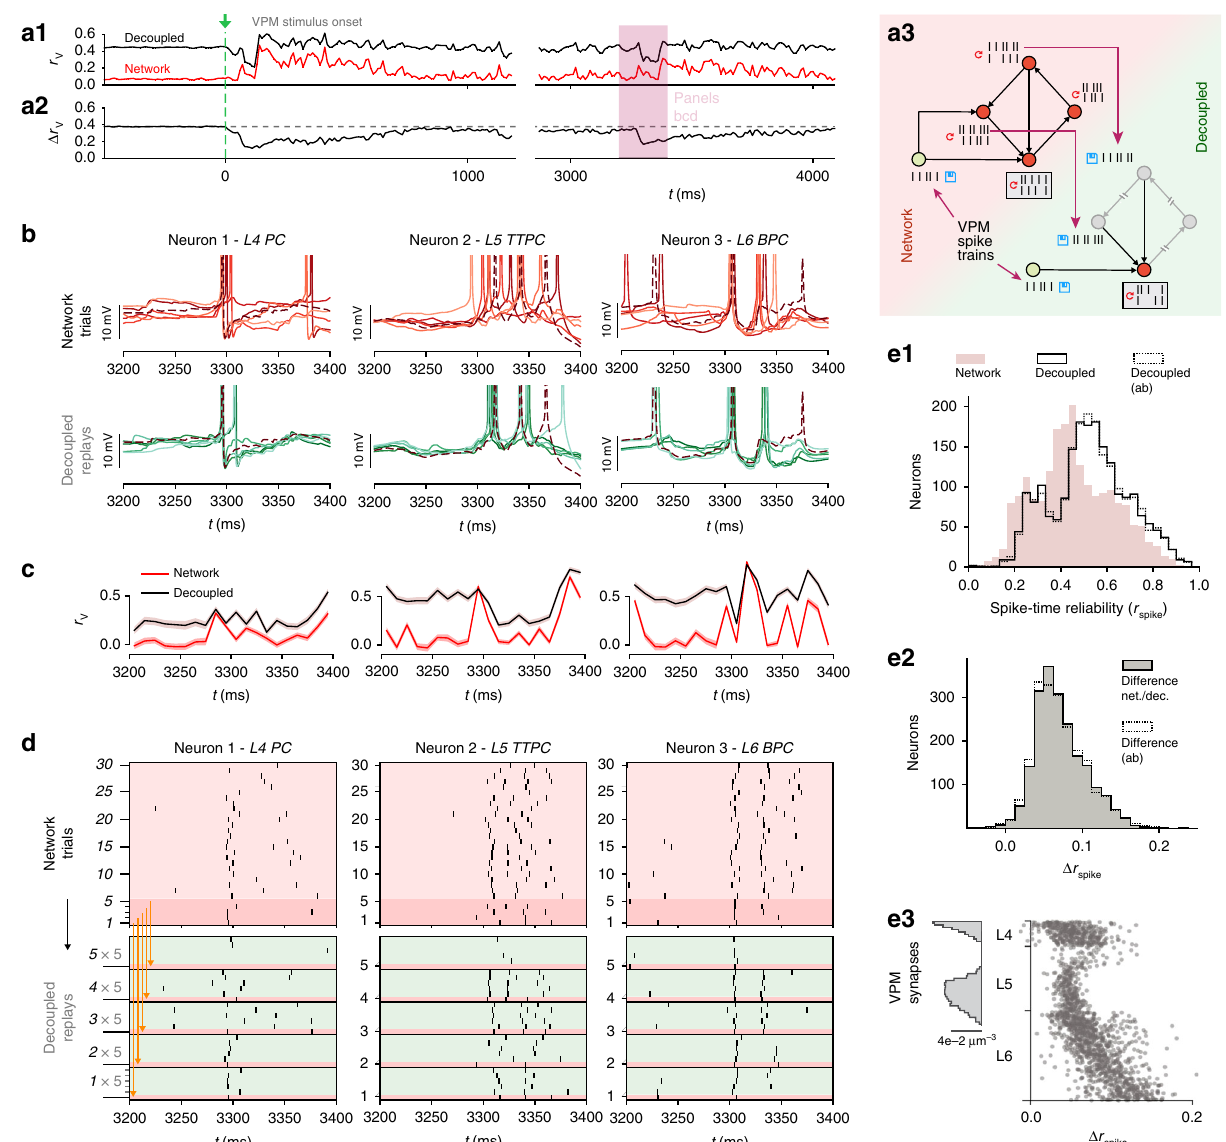
Fig. 6 Spike-time reliability amid noise and chaos. a1 Mean somatic membrane potential correlation, r V , between independent simulations, and between decoupled replays of those simulations (network simulation identical to Fig. 5a2). a2 Difference in r V for decoupled and network simulations. a3 Schematic of network and decoupled replay simulation paradigms, including thalamic input. b Somatic membrane potentials ( V m ) of three representative neurons for the time interval highlighted by the red box in a . Top: during six independent trials. Bottom: fi ve decoupled replay trials (green) with the same presynaptic input as during the original network simulation trial (red), but with different random seeds. c Network and decoupled r V as in a , but only for the three sample neurons in b . d Top: Raster plot of spike times of the same three example neurons as in b , during 30 independent trials of evoked activity. Bottom: Decoupled replay trials (green) of the same input received during 5 of the 30 original trials (dark red). e1 Mean spike-time reliability r spike of 2024 pyramidal neurons from layers 4, 5, and 6 between independent network simulations, and between decoupled replay simulations with identical presynaptic inputs. e2 Difference between r spike of decoupled and replayed simulations. e3 Difference between r spike of decoupled and replayed simulations vs. position of somata across layers 4, 5, and 6 of microcircuit (1675